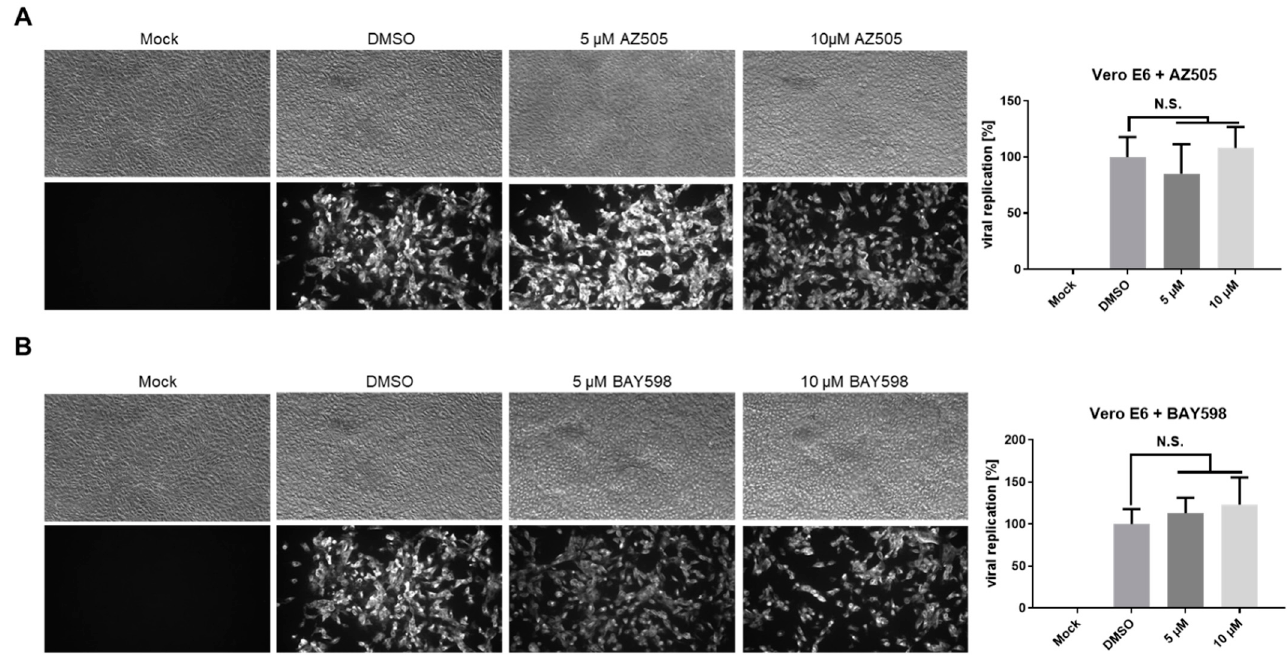
Figure 6. SMYD2 inhibition does not affect SARS-CoV-2 infection of Vero E6 cells. ( A , B ) Antiviral effect of AZ505 and BAY598 in Vero E6 cells. Cells were treated with the indicated concentrations for 24 h prior to infection. The same amount of inhibitor was also applied together with the virus (MOI = 0.005). SARS-CoV-2 positive cells were visualized two days post-infection using a mAb against Spike and an Alexa488-conjugated secondary antibody under a Nikon Inverted Ts2-FL Eclipse microscope equipped with a 10× objective. The Alexa488 signal was quantified in a Victor X4 multilabel reader. Bar graphs represent mean values of eight infected wells ± SD. N.S., not significant. One representative experiment out of three replicates is shown.